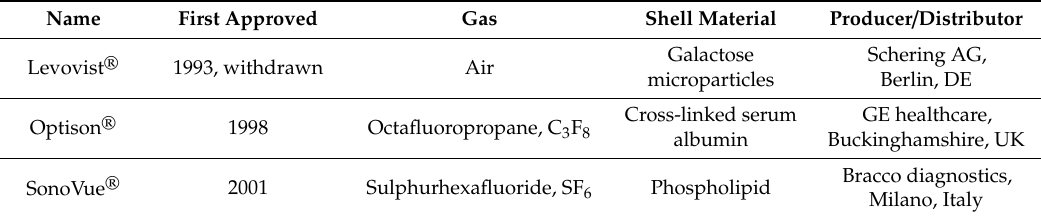
Table 1. Ultrasound contrast enhancers having been used in brain perfusion studies (adapted from